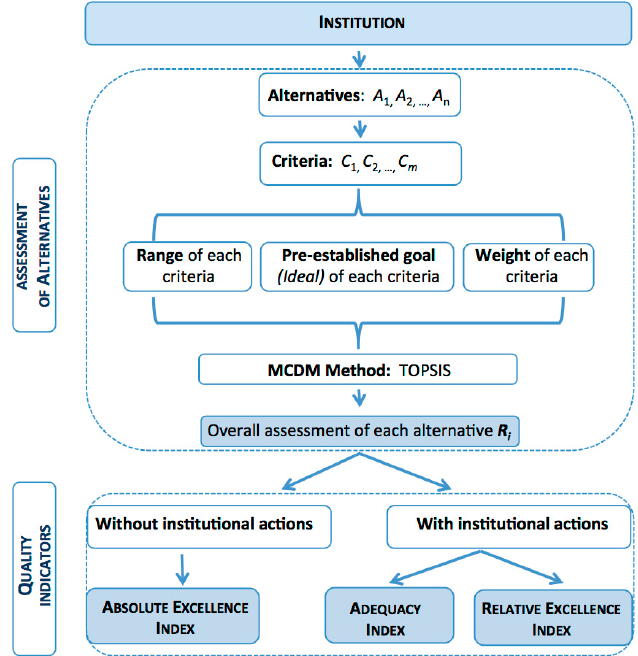
Figure 1. Scheme of our proposal.